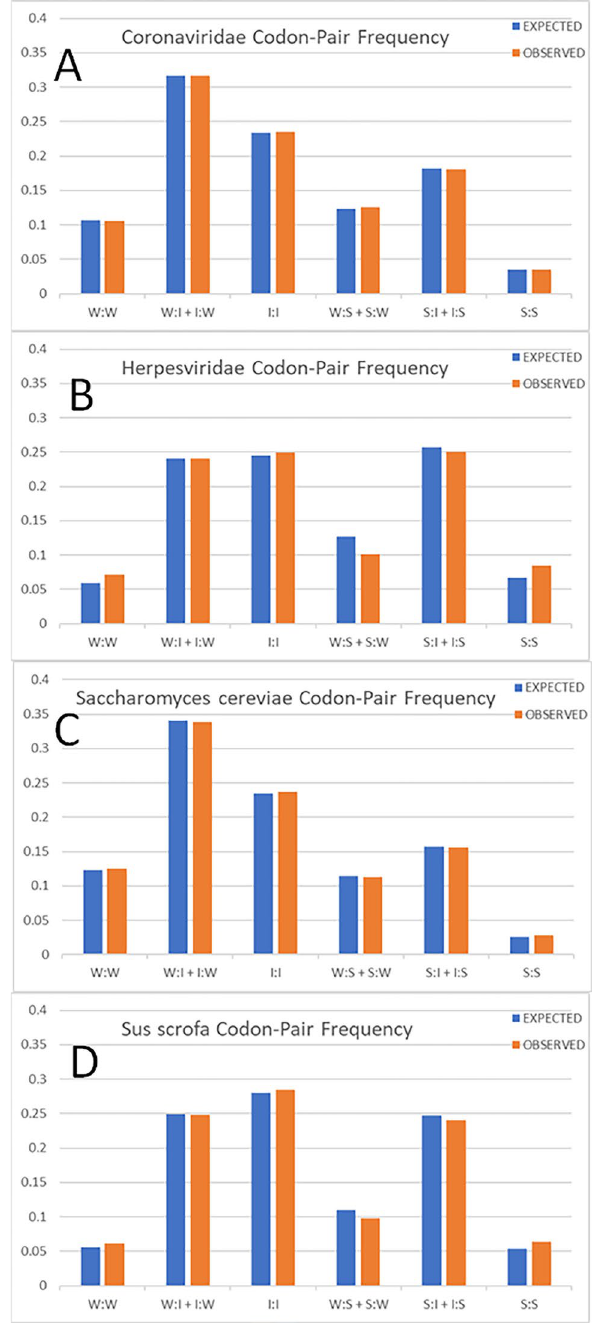
Figure 2. Codon-Pair Frequencies for ( A ), Coronaviridae; ( B ), Herpesviridae; ( C ), Saccharomyces cerevisiae ; and ( D ), Sus scrofa . The frequency is shown on the y-axis, blue columns show the expected frequency, and orange columns show the observed frequency. The columns are grouped by network interaction strength associated with each codon: W for weak, I for intermediate, and S for